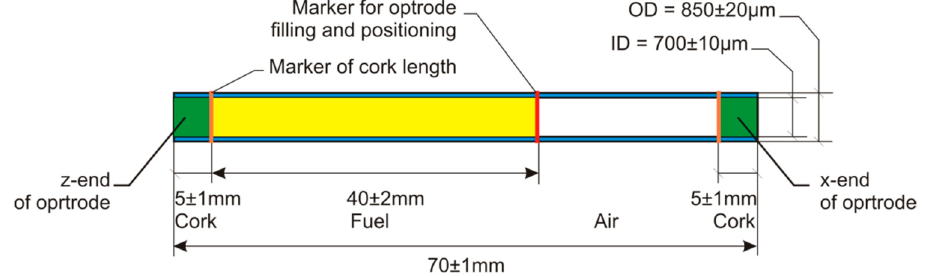
Figure 4. Capillary optrode properly prepared for fuel examination, based on [40].